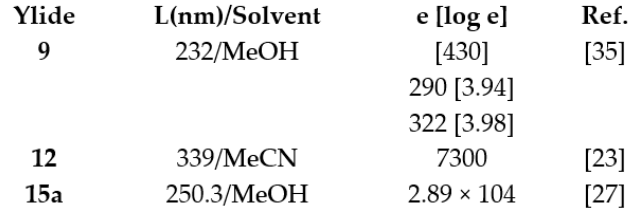
Figure 14. UV data for selenonium ylides, 9 , 12 , and 15a .